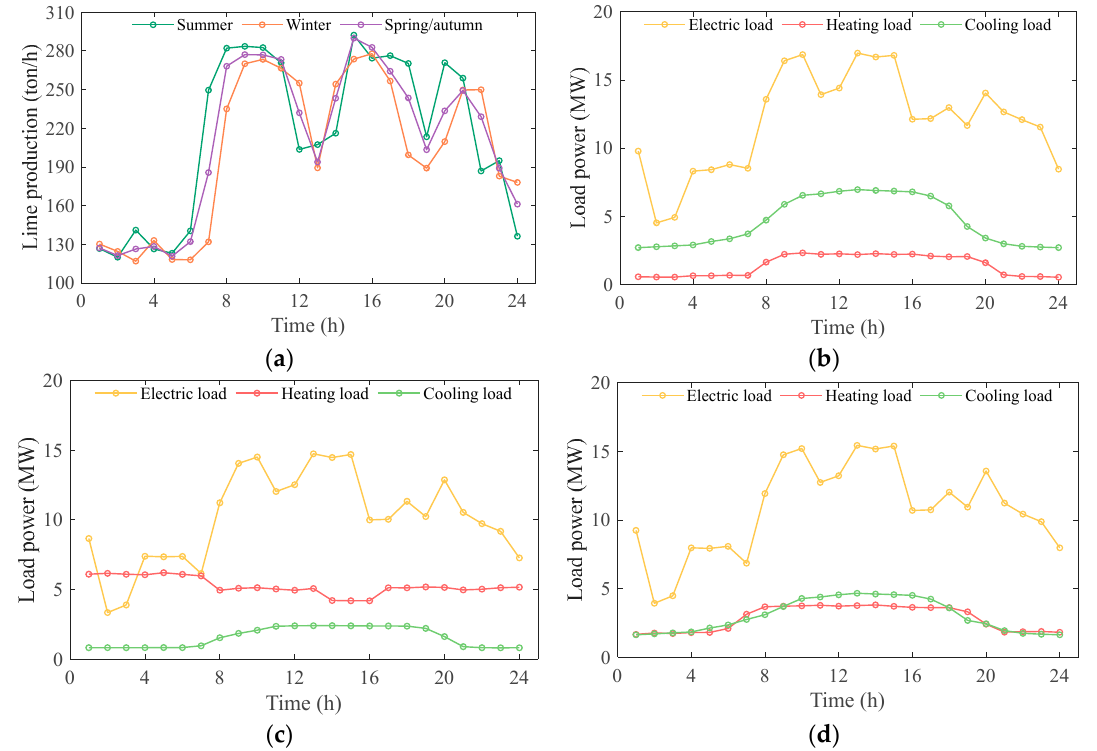
Figure 3. Characteristics of Cement Production and Seasonal Load of Cement Factory: ( a ) Cement Production; ( b ) Summer Load; ( c ) Winter Load; ( d ) Transition Season Load